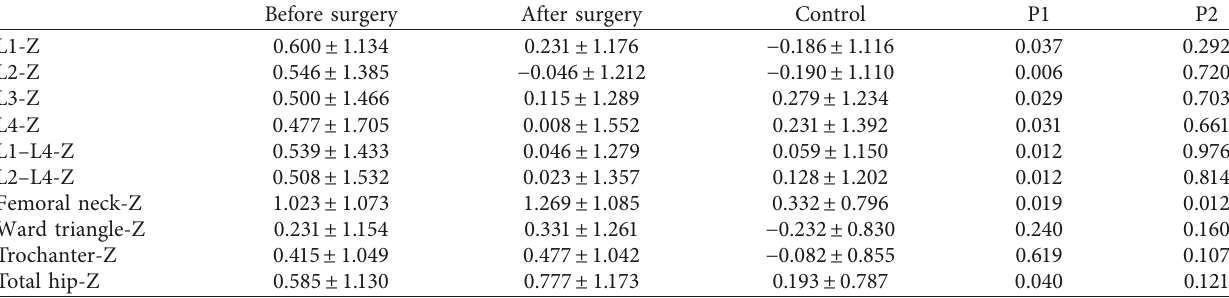
Table 3: Postoperative BMD Z score changes in patients with